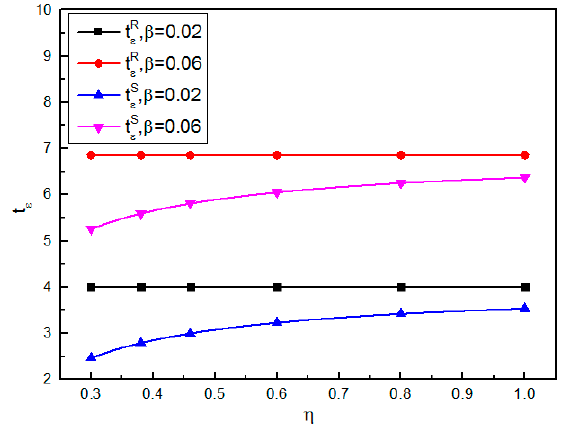
Figure 2. Variation of t ε with η for different values of β .